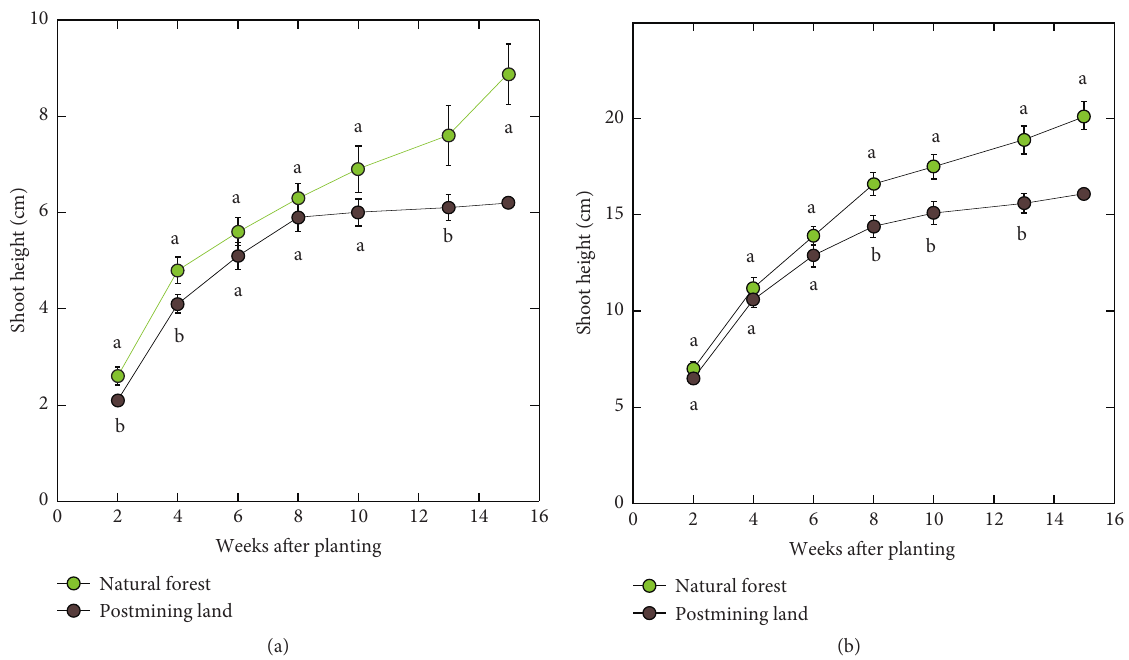
Figure 3: Shoot height of Falcataria moluccana (a) and Albizia saman (b) grown on natural forest soils and post bauxite mining soils for 15 weeks under greenhouse conditions. Different letters of each week indicate a significant difference ( P < 0 . 05) by the t test. Mean ± standard error is shown ( n � 15).